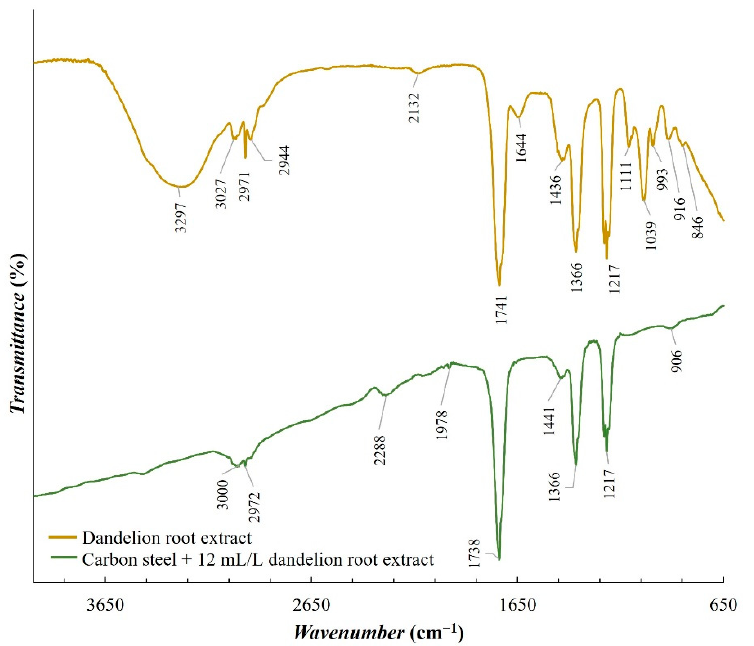
Figure 12. FTIR spectra of dandelion-root extract and the carbon-steel sample after 4 h of immersion